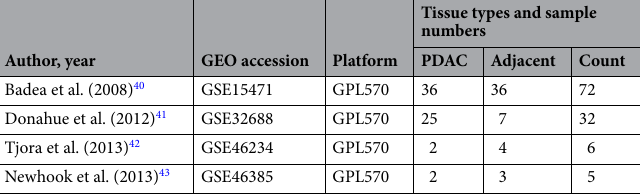
Table 3. Information of datasets in the analysis of PDAC tissues vs. normal or adjacent